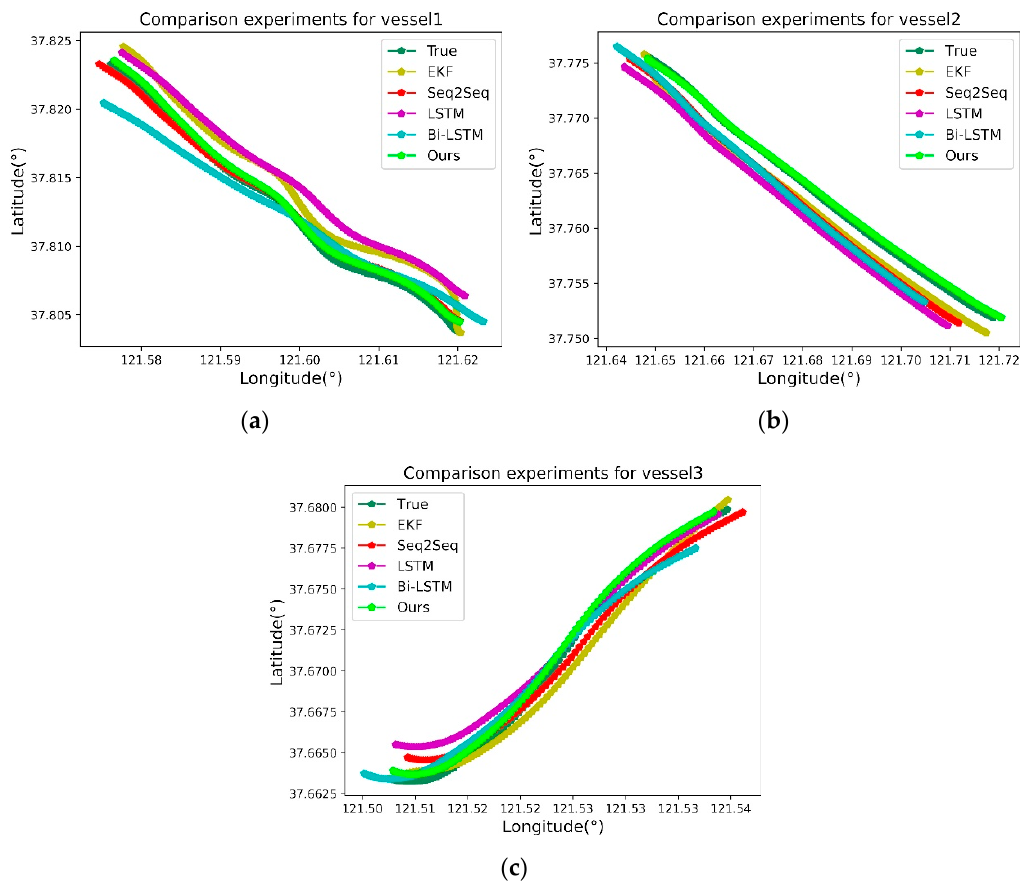
Figure 13. The effect of the compared methods is shown. The prediction results of the proposed method and other mainstream algorithms including EKF, Seq2Seq, LSTM and Bi-LSTM for the three trajectories are shown in ( a – c ), respectively. Table 3. Comparison of the proposed method with other four baseline methods for different